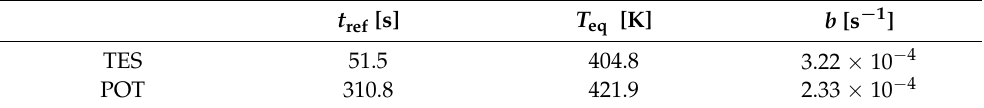
Figure 5. Volume averaged temperature evolution in the solar cooker. ( Left ) Temperature of the TES and ( Right ) temperature of the pot. Table 1. Fitting parameters of the average temperature profiles of the TES and